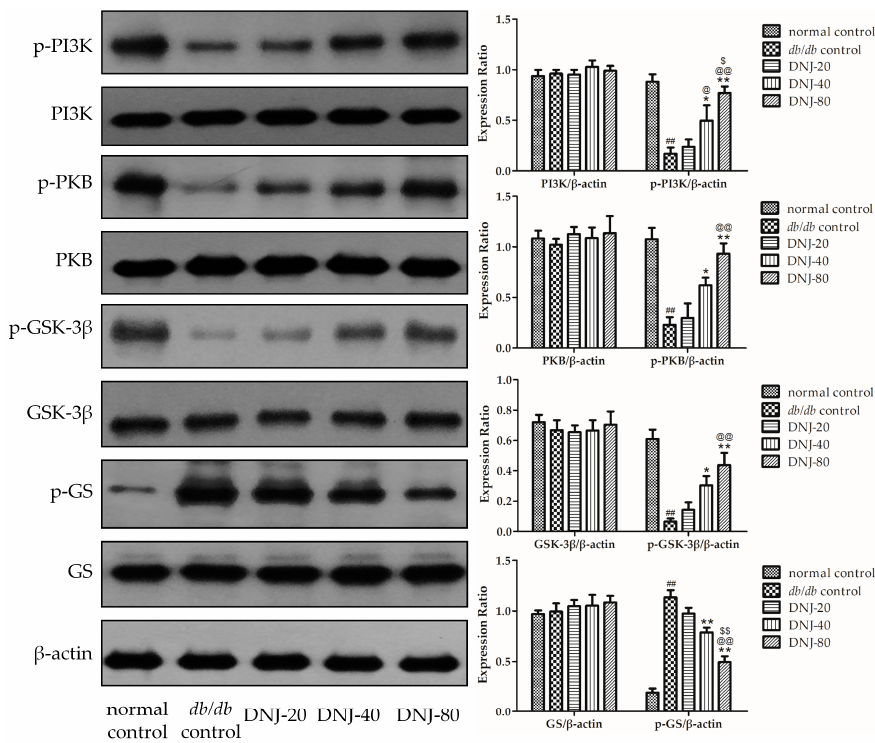
Figure 7. Effect of DNJ on PKB/GSK-3 β signal pathway in the liver of db/db mice. Expressions of phosphatidylinositol 3 kinase (PI3K), protein kinase B (PKB), glycogen synthase kinase 3 β (GSK-3 β ), glycogen synthase (GS) and their phosphorylation were determined. ## p < 0.01 vs. normal control. * p < 0.05, ** p < 0.01 vs. db/db control, @ p < 0.05, @@ p < 0.01 vs. DNJ-20, $ p < 0.05, $$ p < 0.01 vs. DNJ-40 ( n = 3).